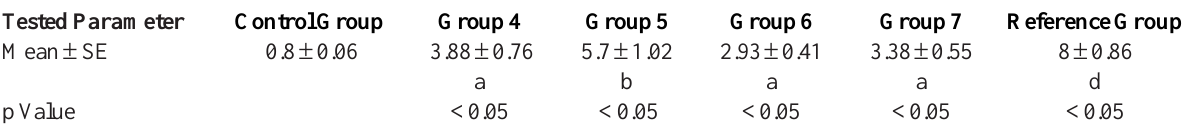
Table 2 – Mean free serum testosterone level (pg/mL) among groups of rats treated with different fractions of 70% alcoholic extract of aerial part without fruits of Tribulus alatus.